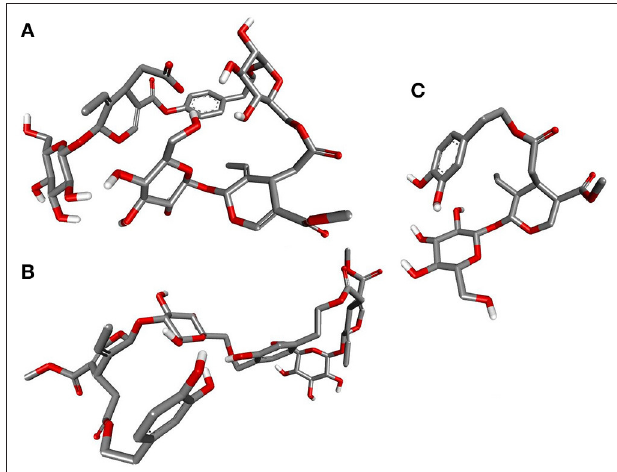
FIGURE 12 | Closeup of 3D conformations of (A) Nüzhenide oleoside (B) Oleuropein dimer (C) Dihydro oleuropein exposing the shape of the active secoiridoids at the SARS-CoV-2-ACE-2 interface. The perfect “U” shape acquired by the ligands is significant for binding.